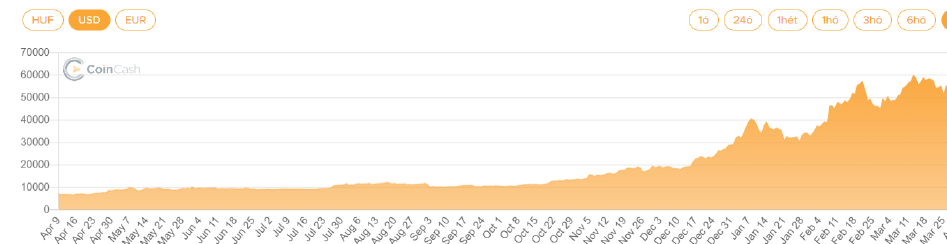
Figure 1. One-year Bitcoin rates in USD.